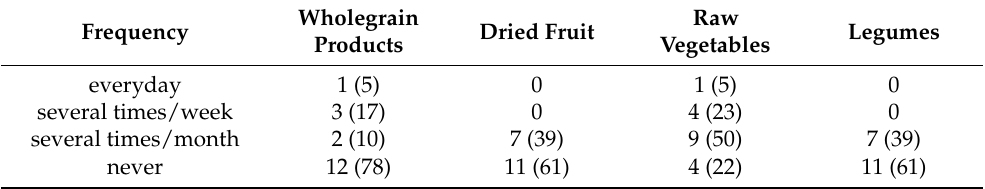
Table 3. Frequency of consumption of selected food groups in patients with active IBD.